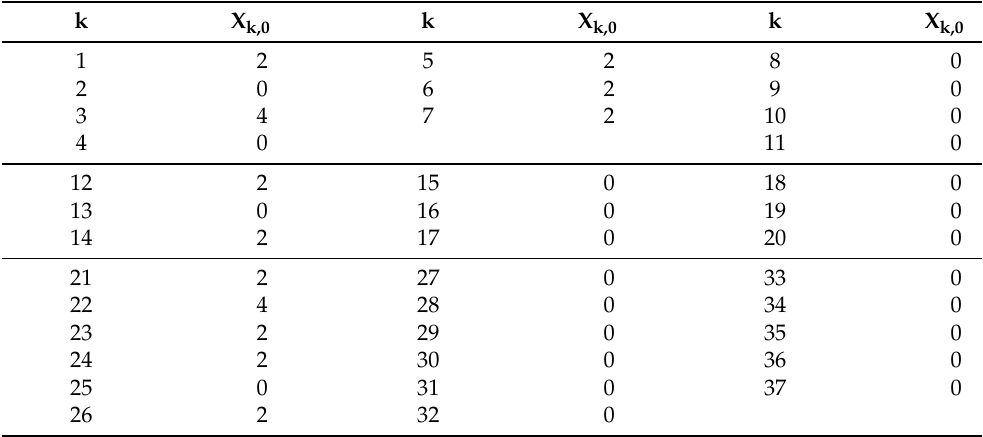
k X k,0 k X k,0 k X